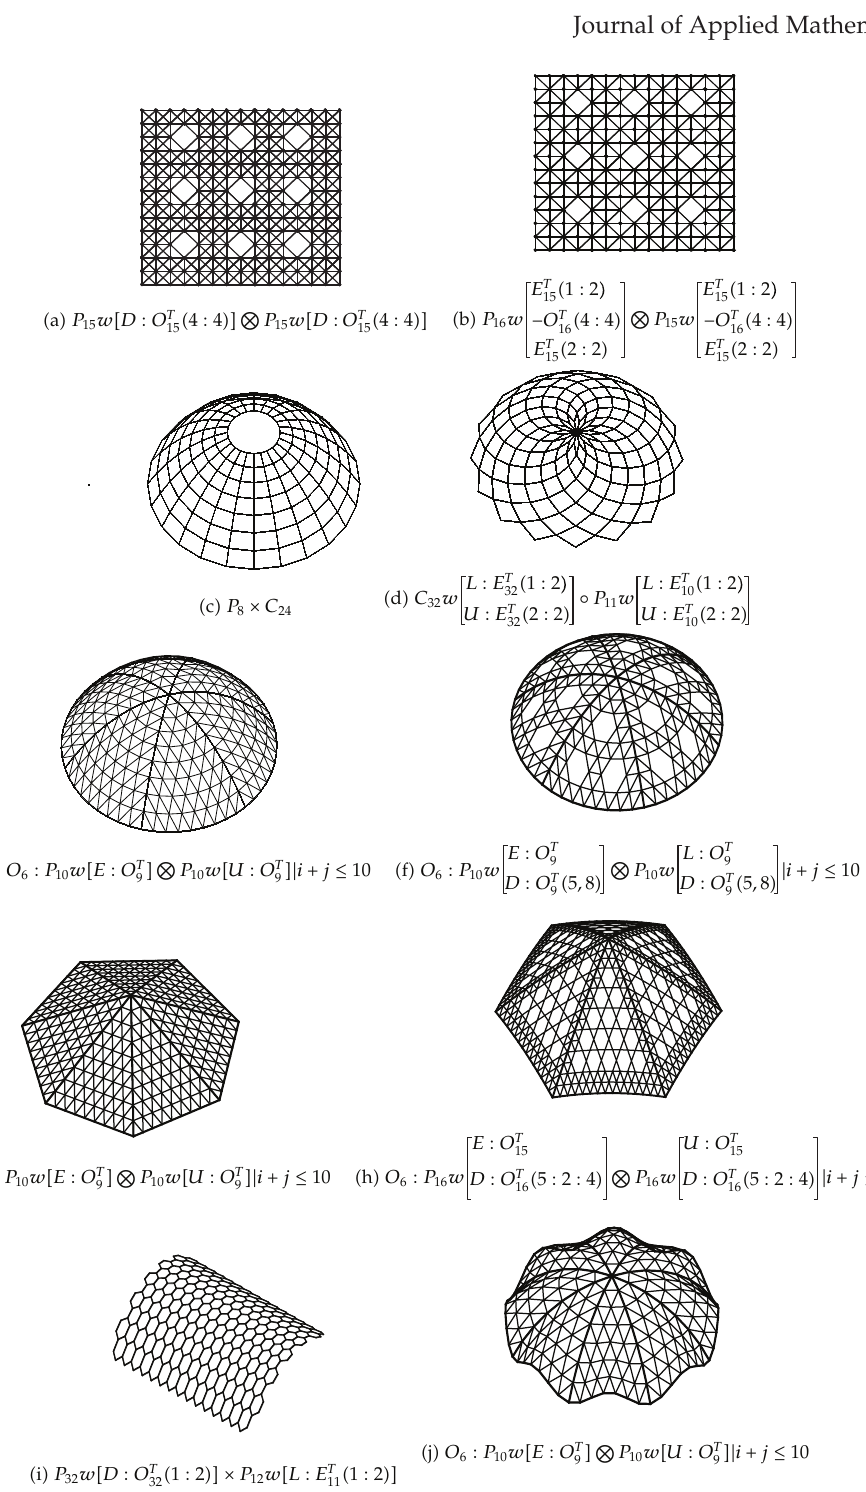
Figure 15: Di ff erent configurations in generalized graph